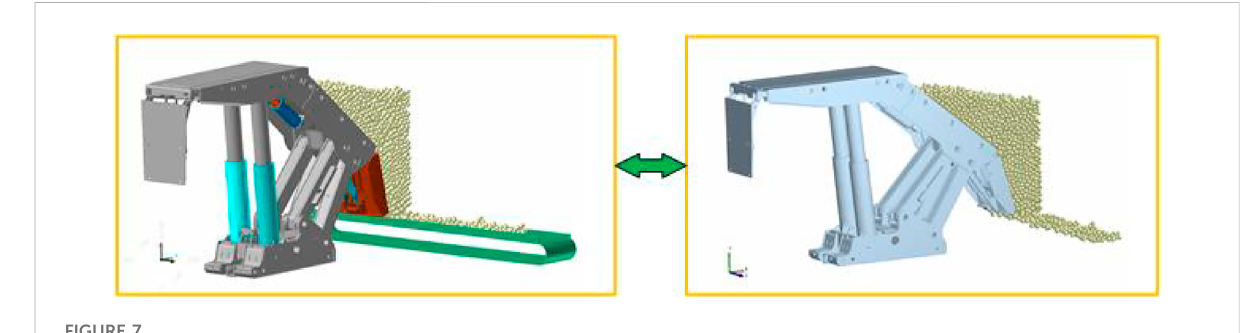
FIGURE 7 RecurDyn – EDEM bi-directional coupling simulation